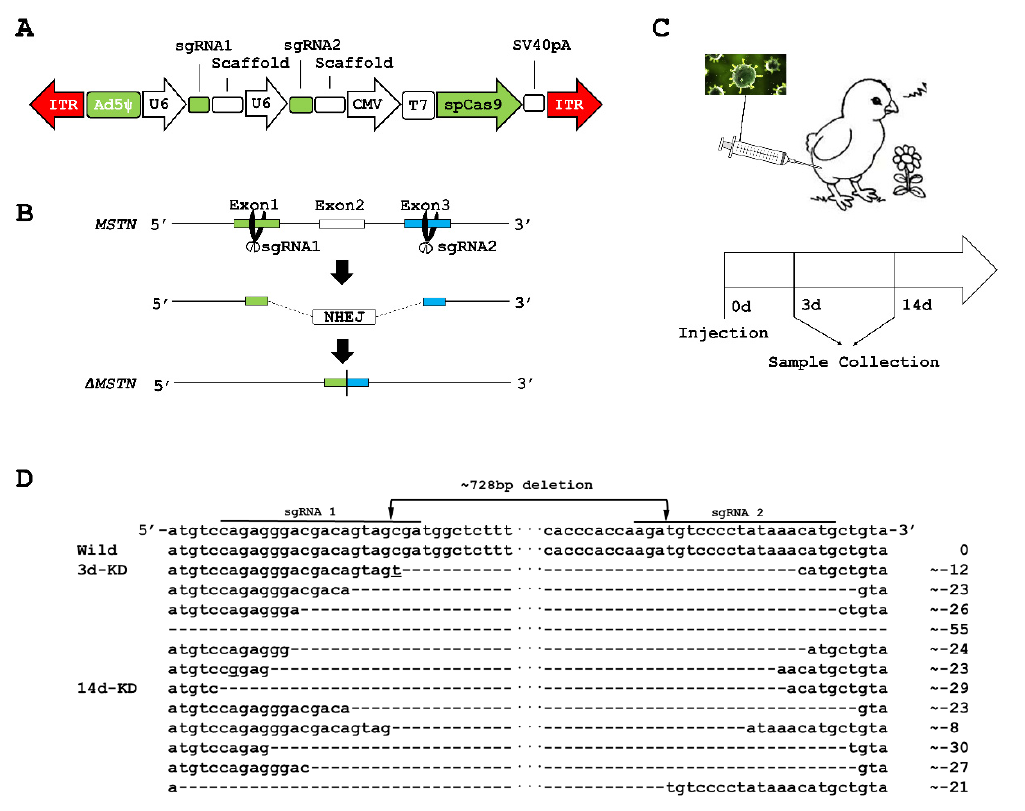
Figure 1. Preparation and validation of MSTN knockout (KO) muscles. ( A ) Schematic of the AdV-CRISPR system used in this study. ( B ) Strategy for large fragment deletion of the chick locus by non-homologous end joining (NHEJ). ( C ) Mode of AdV-CRISPR system delivery and experimental design. ( D ) Sequencing of the RT-PCR product from muscles injected with the AdV-CRISPR system.